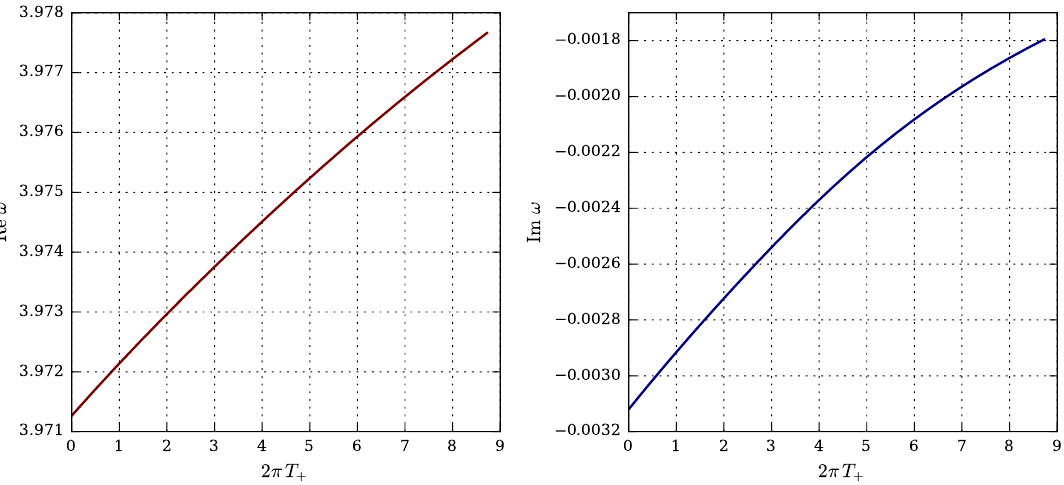
√ = 2 . We note that the temperature +